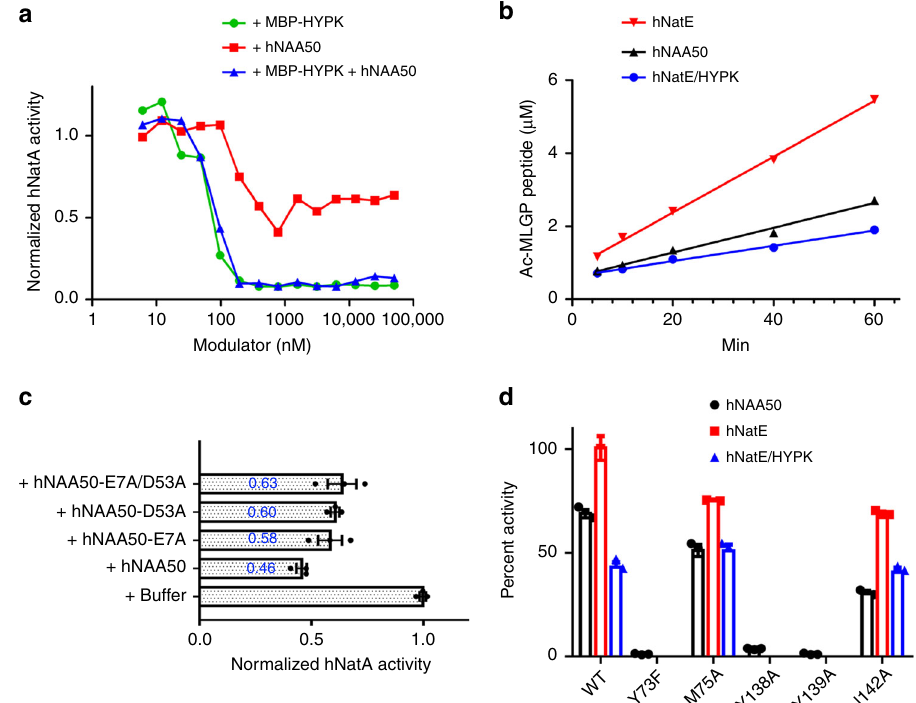
Fig. 2 HYPK binding negatively affects hNatE acetylation activity. a Either MBP-HYPK (green), hNAA50 (red), or both (blue) are titrated into hNatA (100 nM) to evaluate their modulatory effect on hNatA activity against an SASE peptide substrate. A best line is drawn through the data points for ease of visualization. Source data are provided as a Source Data fi le. b Comparison of time course acetylation activity of hNAA50 (black), preformed hNatE (red), and preformed hNatE/HYPK (blue; all 500 nM) against an MLGP peptide substrate. Source data are provided as a Source Data fi le. c hNatA acetylation activity against an SASE peptide with addition of buffer, wild type (WT), or hNAA50 mutants. Errors were reported in SEM with n = 3 independent experiments. Source data are provided as a Source Data fi le. d Activity of hNAA50 WT and mutants against MLGP peptide was tested, either alone (black), in the context of hNatE ( + hNatA; red), or in the context of preformed hNatE/HYPK ( + hNatA/HYPK; blue). Data were normalized to WT hNatE activity as 100%, represented as mean ± SD, n = 3 independent experiments. Source data are provided as a Source Data fi le.